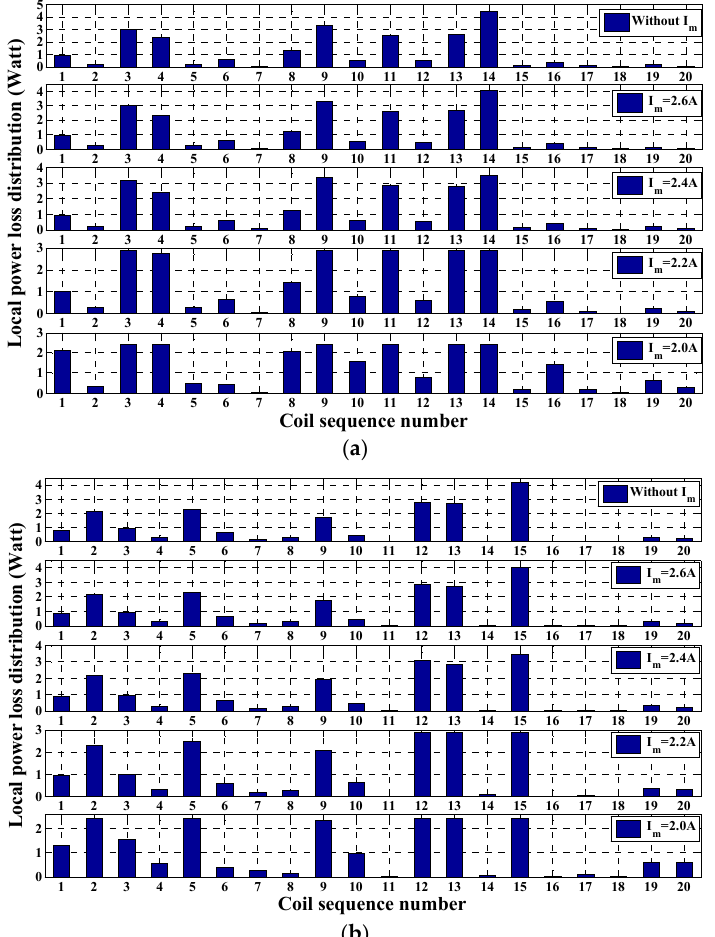
Figure 7. Local power loss distribution in position ( a ) x = − 6.896 mm and ( b ) x = − 4.774 mm when commutations are optimized without boundary constraint I m , with boundary constraint I m = 2.6 A, 2.4 A, 2.2 A, and 2.0 A, respectively